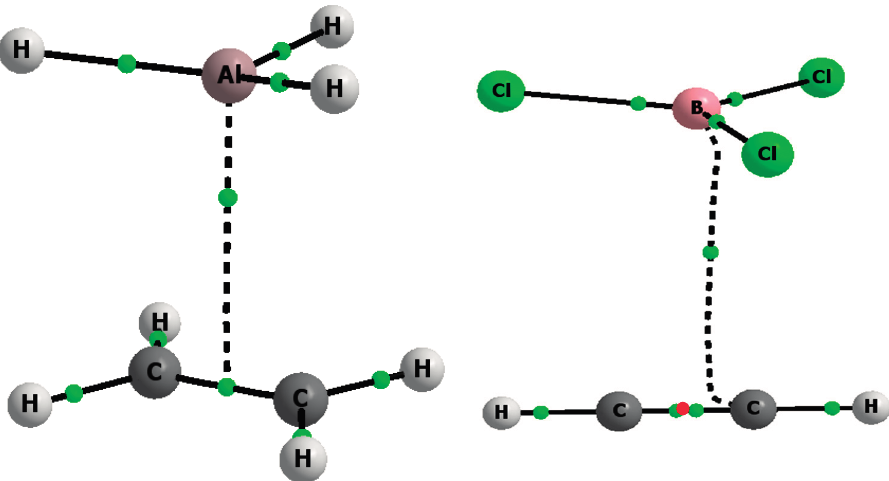
Figure 2. The molecular graphs of the AlF 3 -C 2 H 2 ( the top left ), AlBr 3 -C 2 H 4 ( the top right ), AlH 3 -C 2 H 4 ( the bottom left ) and BCl 3 -C 2 H 2 ( the bottom right ) complexes, big circles correspond to attractors, small green circles to the bond critical points, small red circles to the nonnuclear attractors and the solid and broken lines to the bond